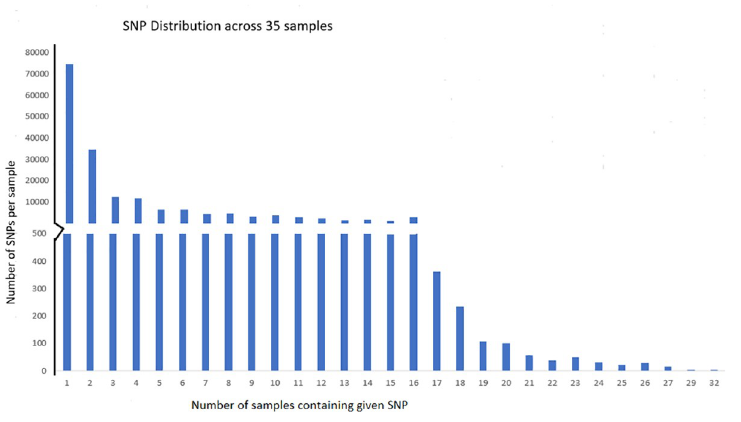
Fig 1. SNV distribution across 35 samples.